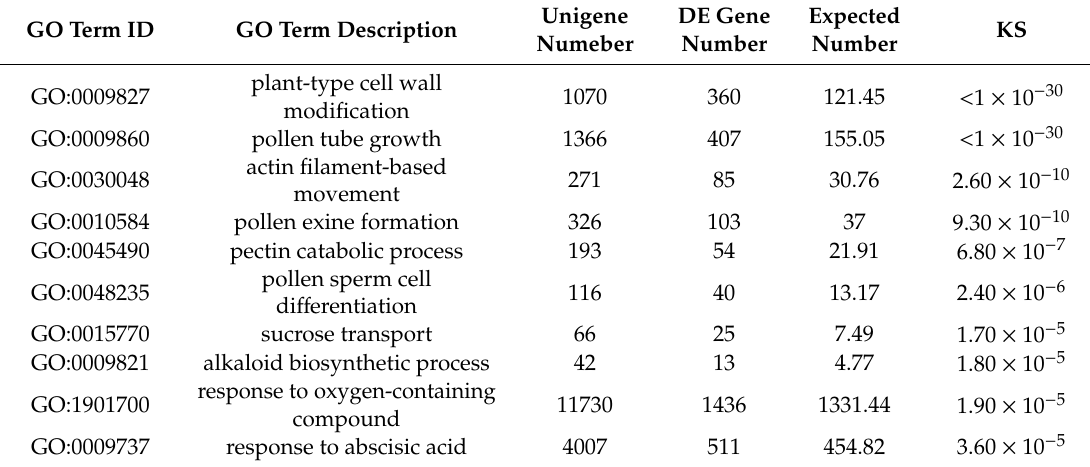
Table 3. Top 10 GO terms in BP category of di ff erentially expressed genes in Bcpol97-05A (sterile line) compared to Bcajh97-01B (fertile line) of Brassica campestris .